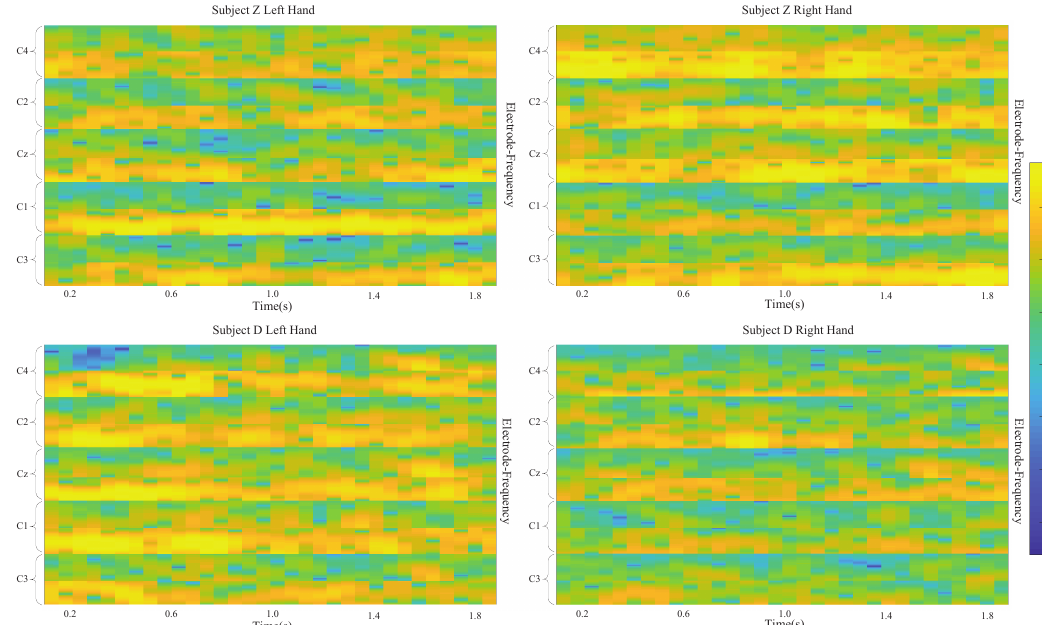
Figure 9. input images for left- and right-hand classes of subject D and subject Z.